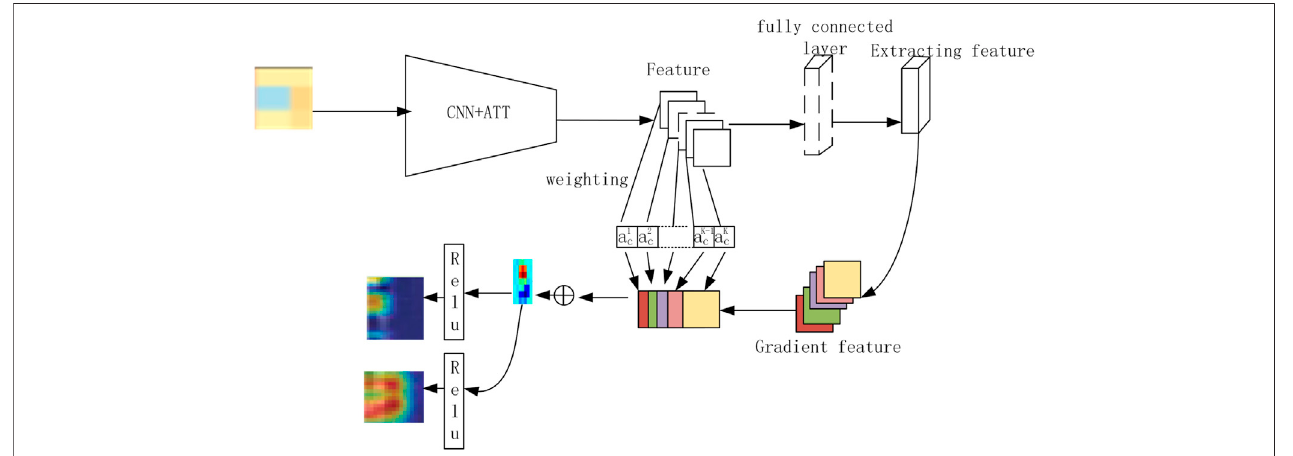
FIGURE 2 | Process of generating the pathway